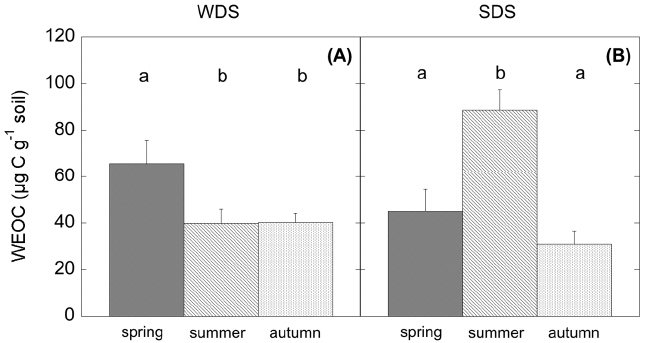
Figure 4. Water-extractable organic carbon (WEOC ± s.e.) in winter deciduous (WDS) ( A ) and summer deciduous (SDS) ( B ) sites, during the three seasons. Different letters show significant differences ( p < 0.05) among the seasons. Spring = grey; Summer = dashed; Autumn = white.